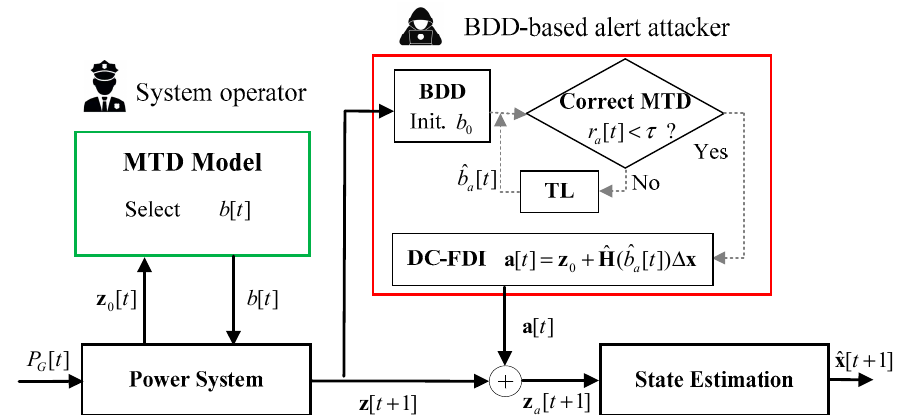
Figure 1. The attack logic flowchart of the BDD-based alert attacker.